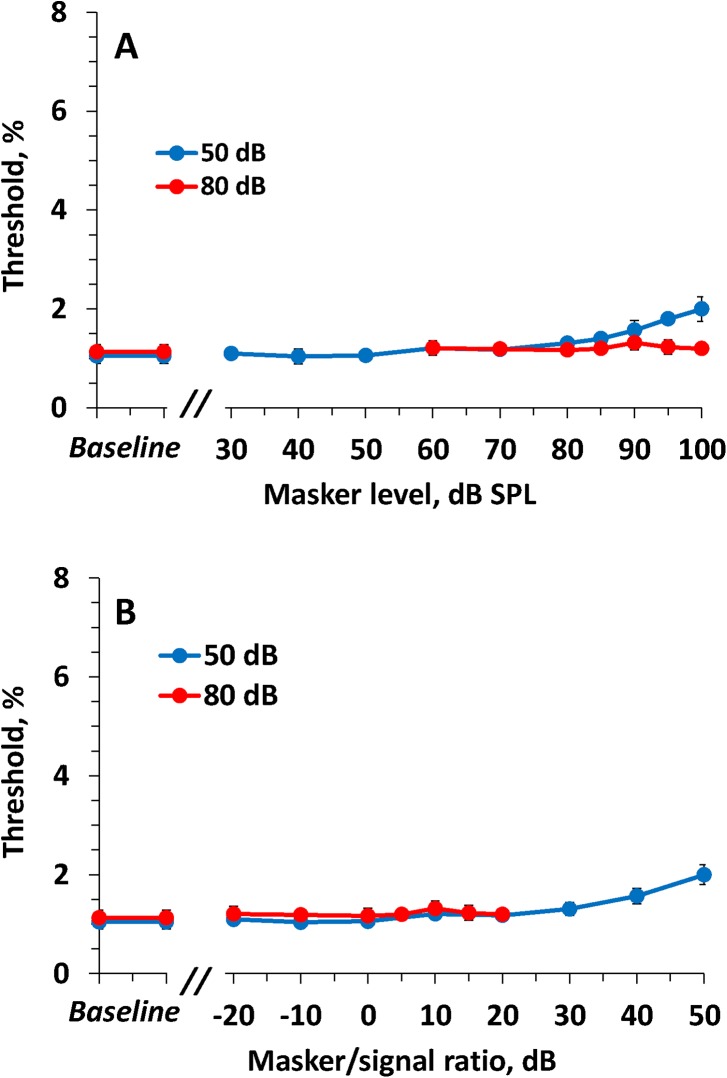
The same as Fig 4 for the high-frequency masker.The effect of masker was negligible except the highest (>30 dB) masker/signal ratios.